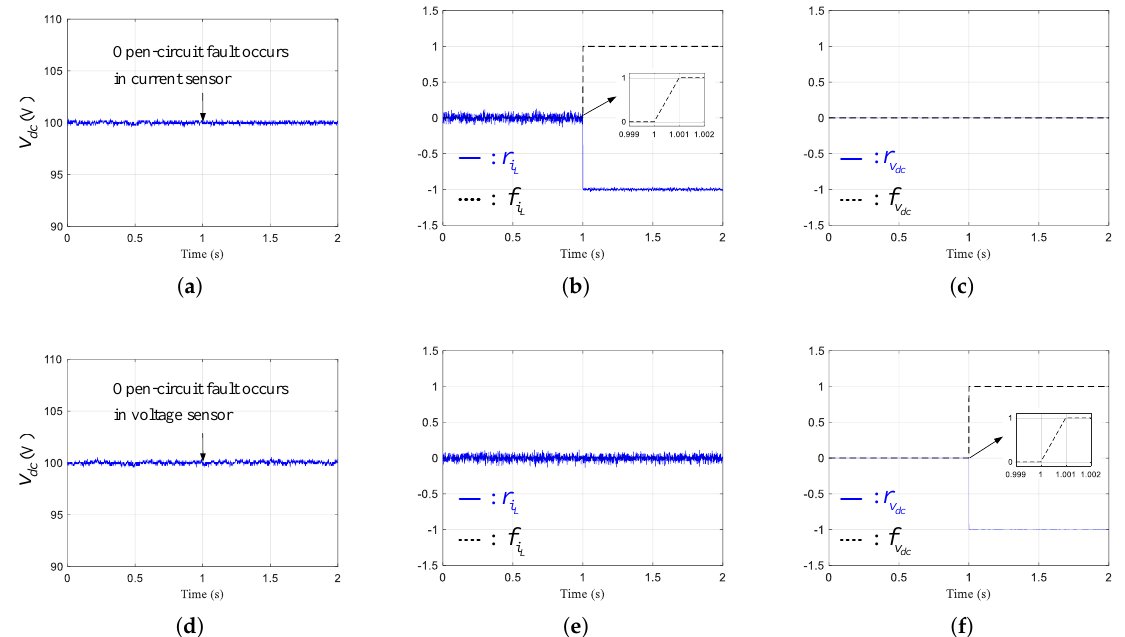
Figure 6. Output voltage, normalized residuals and fault flags of the proposed observer under an open-circuit fault condition in the current sensor ( a – c ) and voltage sensor ( d – f ).